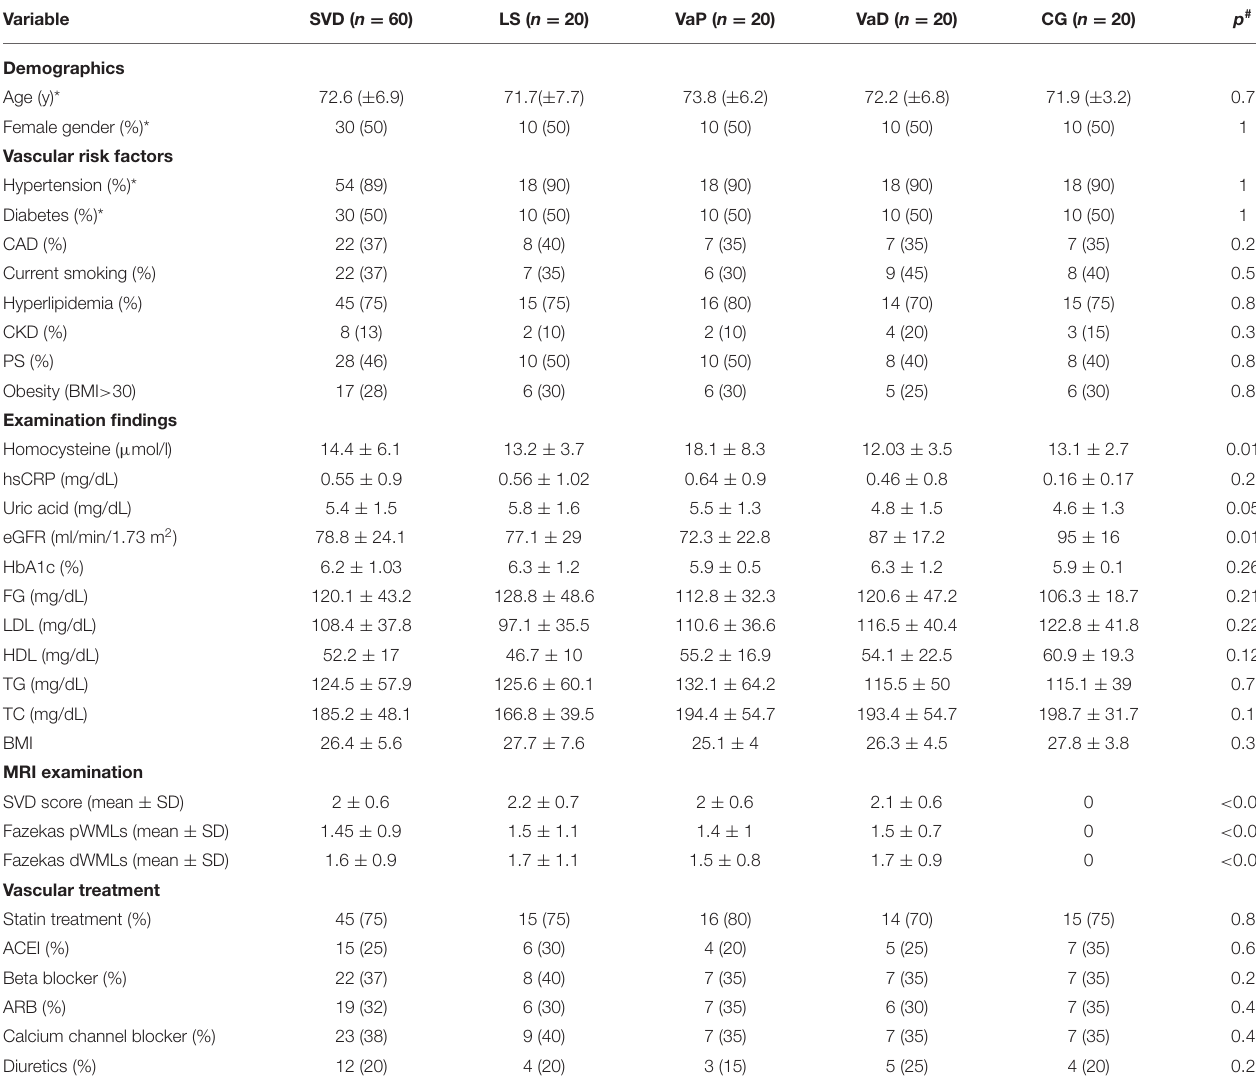
TABLE 1 | Main characteristics of the study population at baseline.